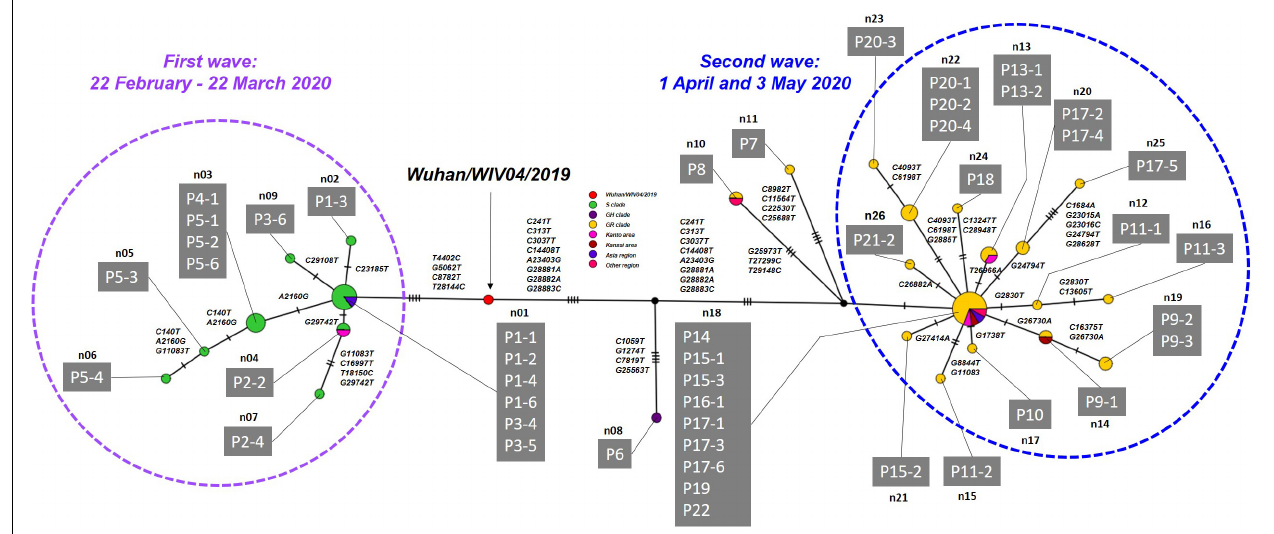
FIGURE 5 | Haplotype network using genome-wide SNVs (HN-GSNVs) in Niigata City, Japan, between February and May 2020 ( n = 47). The purple dotted circle represents the first wave by the date of onset (between 22 February and March 22, 2020) and the light blue dotted circle represents the second wave by the date of onset (between 01 April and May 03, 2020). Red circles indicate the reference sequence (Wuhan/WIV04/2019), green circles the S clade, dark purple circles the GH clade, and yellow circles the GR clade. Pink circles indicate the clusters of Kanto area prefectures isolates (Tokyo, Chiba, Kanagawa, Saitama, Gunma, and Tochigi), dark red circles the clusters of Kansai area prefectures isolate (Osaka, Kyoto, Hyogo, Shiga, Nara, and Wakayama), purple circles the clusters of Asia region isolate, and dark pink circles the clusters of other regions isolate. Haplotype clusters including each patient are represented as n01 to n26, respectively. Branches are labeled with SNVs. The case ID of each patient corresponds to the transmission chain in Figure 3 and detailed epidemiological information of Supplementary Table 4 . Detailed list of nucleotide substitutions found in each haplotype constructed in Niigata City isolates compared to reference strain Wuhan/WIV04/2019 is presented in Supplementary Table 5